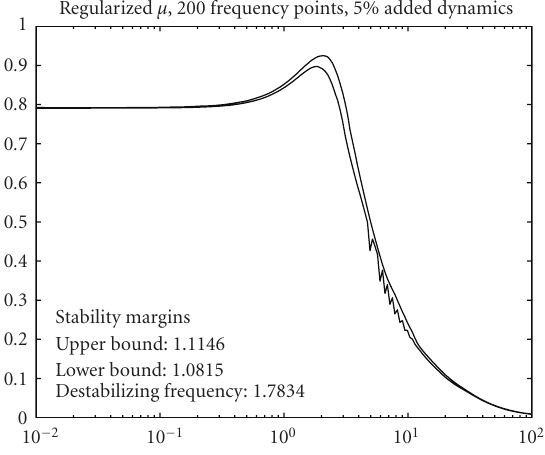
Figure 3: Stability margin bounds for lateral dynamics. Table 5: SVD of longitudinal control distribution matrix a . Left singular vectors Singular